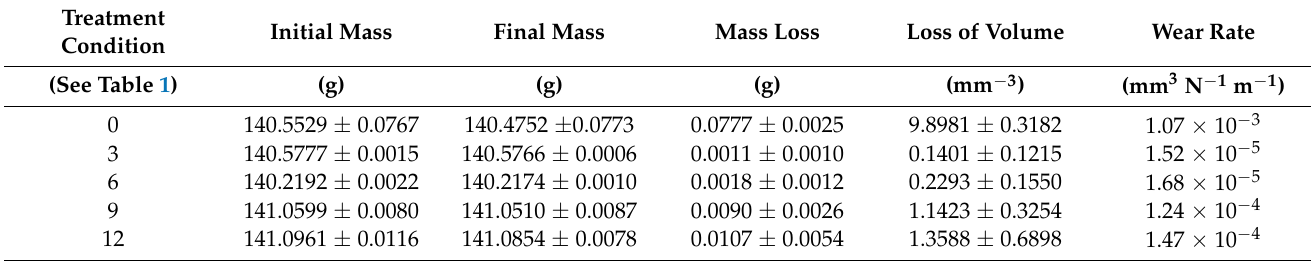
Table 7. Volume loss as a function of the different hardening